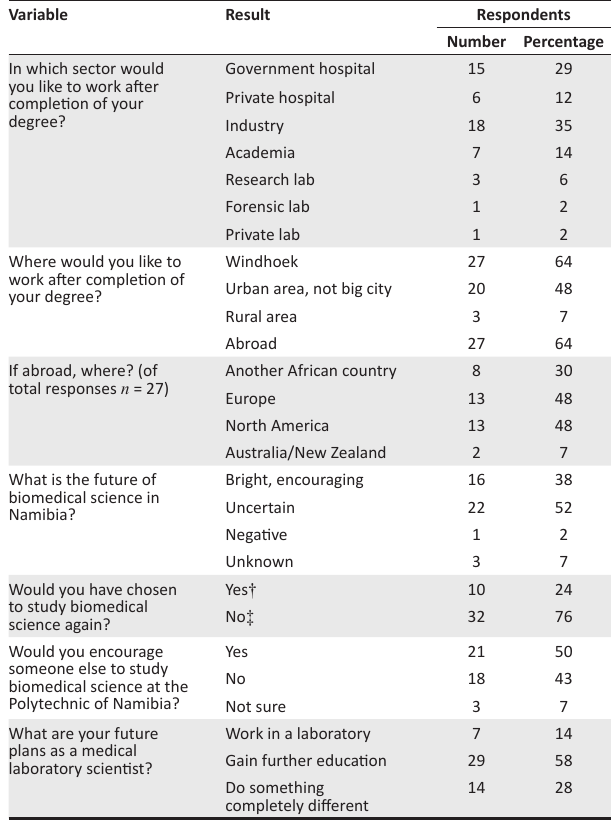
TABLE 3: Future expectations and perceptions of fourth-year students in the Biomedical Science programme at the Polytechnic of Namibia in 2011 and